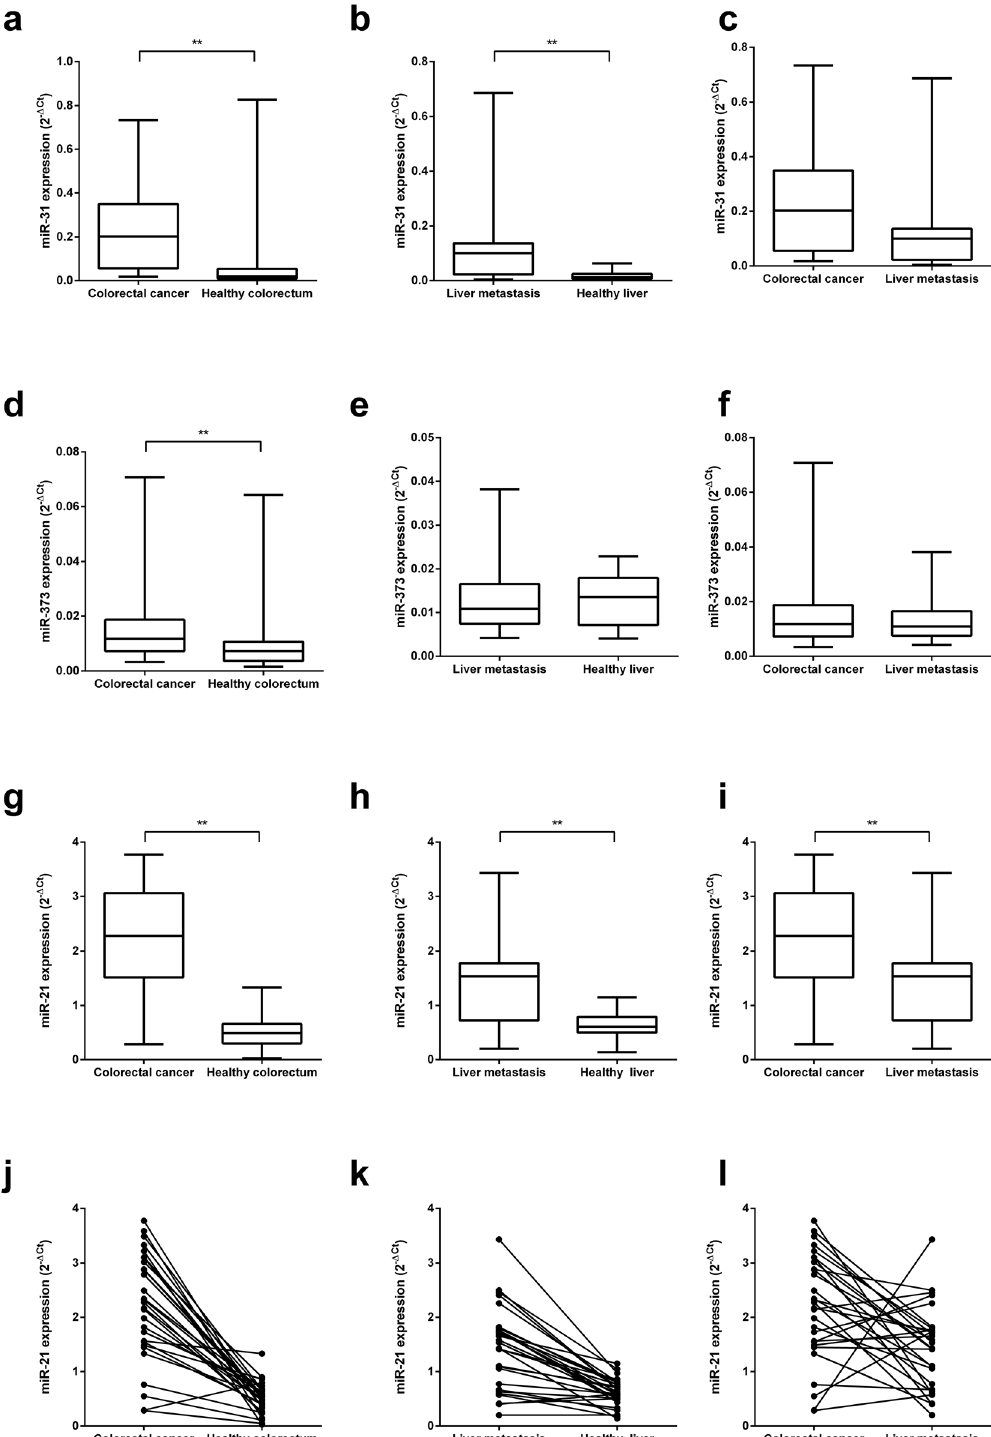
Fig 1. MiRNA expression levels in primary tumors, metastases and corresponding normal tissues of patients with colorectal carcinoma. (a) – (i) Aggregated box-plot comparisons of miRNA-31, miRNA-373 and miRNA-21 expression levels. All miRNAs are significantly higher expressed in colorectal carcinomas (PrTu) than in healthy colorectal mucosa (HeMu) (a, d, g) . Expression in liver metastases (LiMe) is significantly higher than in healthy liver tissue (HeLi) for miRNA-31 (b) and miRNA-21 (h) . A comparison of PrTu and LiMe shows significantly higher miRNA-21 in the primary tumor tissue ( i ; p < 0.01). MiRNA-31 is higher by trend ( c ; p = 0.09). (j) – (l) MiRNA-21 expression is compared on a combined intra- and inter-patient level over the same tissues.